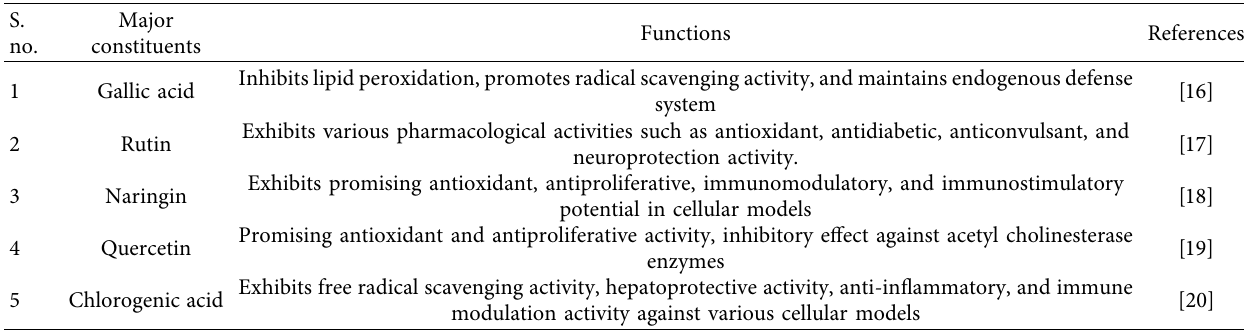
Table 1: Major constituents of TA that exhibit pharmacological